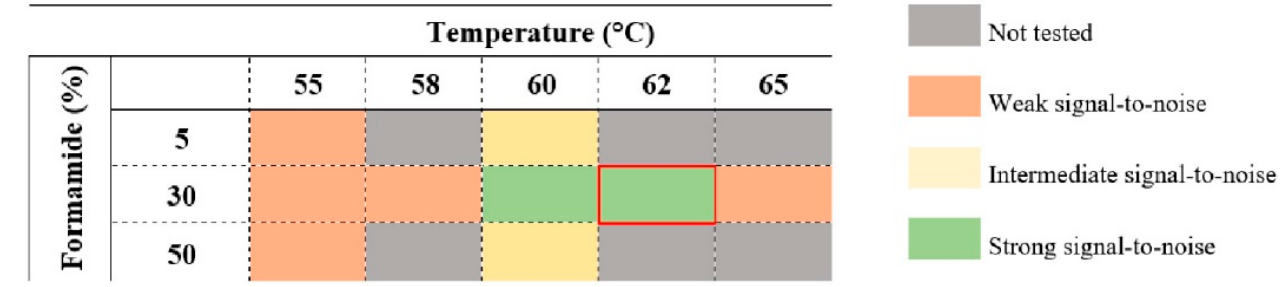
Figure 3. Temperature and formamide concentration assessments for hybridization conditions optimization. The selected conditions for the best performance are 62ºC and 30% formamide (red bracket).